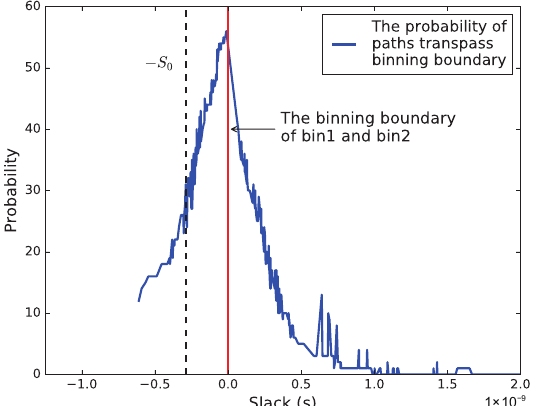
Figure 11. The probability of paths transpassing bin boundaries with different slack. Adaptable margin S 0 is selected according to δ (70% in this implementation).